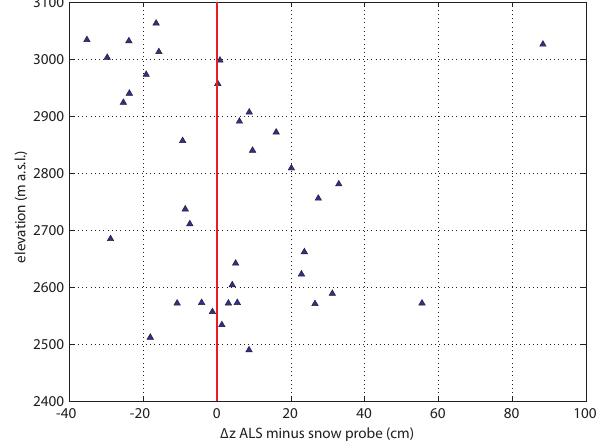
Fig. 7. Difference between ALS elevation change 1z and measured snow depth from snow probing on Hintereisferner (HEF) at the end of accumulation season